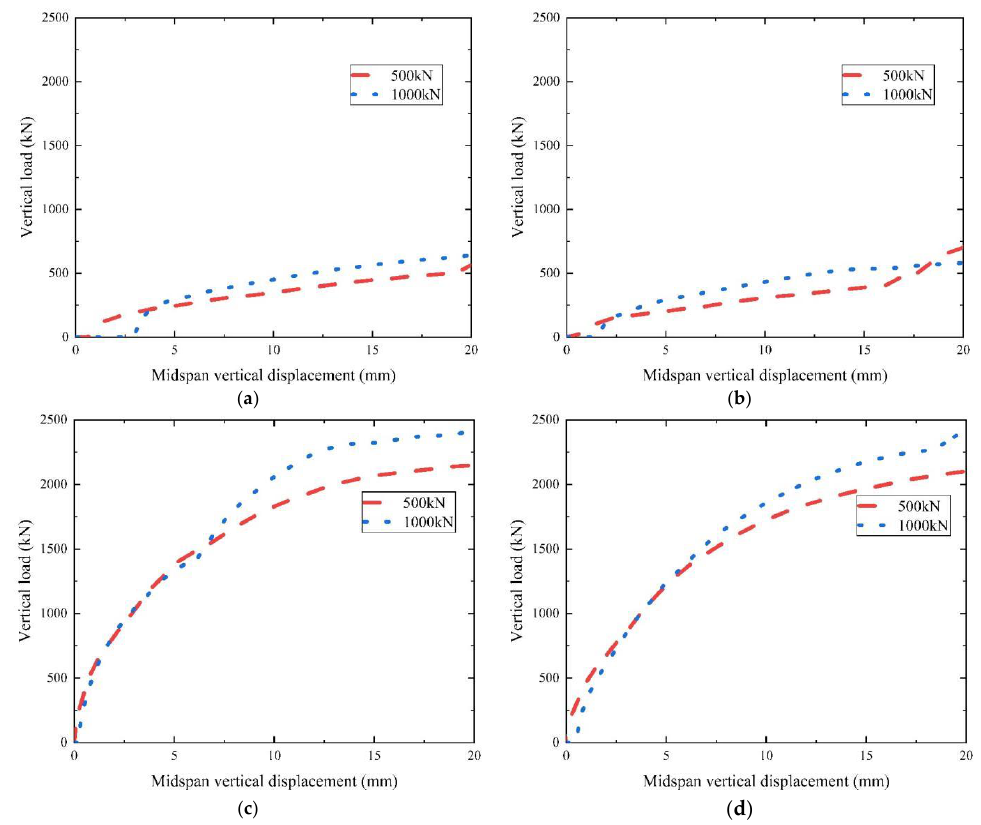
Figure 15. Load – displacement curves of the four joints with different initial axial forces. ( a ) MJ. ( b ) BMJ. ( c ) PJ. ( d ) BPJ. Figure 15 shows that the initial axial force changed from 500 kN to 1000 kN, the ver- tical peak load of the MJ changed from 565 kN to 642 kN, the vertical peak load of the BMJ changed from 703 kN to 581 kN, and the flexural bearing capacity – displacement load curves of the MJ and BMJ did not change much. The vertical peak loads of the PJ and BPJ increased from 2150 kN to 2410 kN and 2105 kN to 2433 kN, respectively. It can be seen that increasing the initial axial force is beneficial for improving the flexural bearing capac- ity of the PJ and BPJ under fire. However, it does not significantly improve the flexural bearing capacity of the PJ and BPJ.